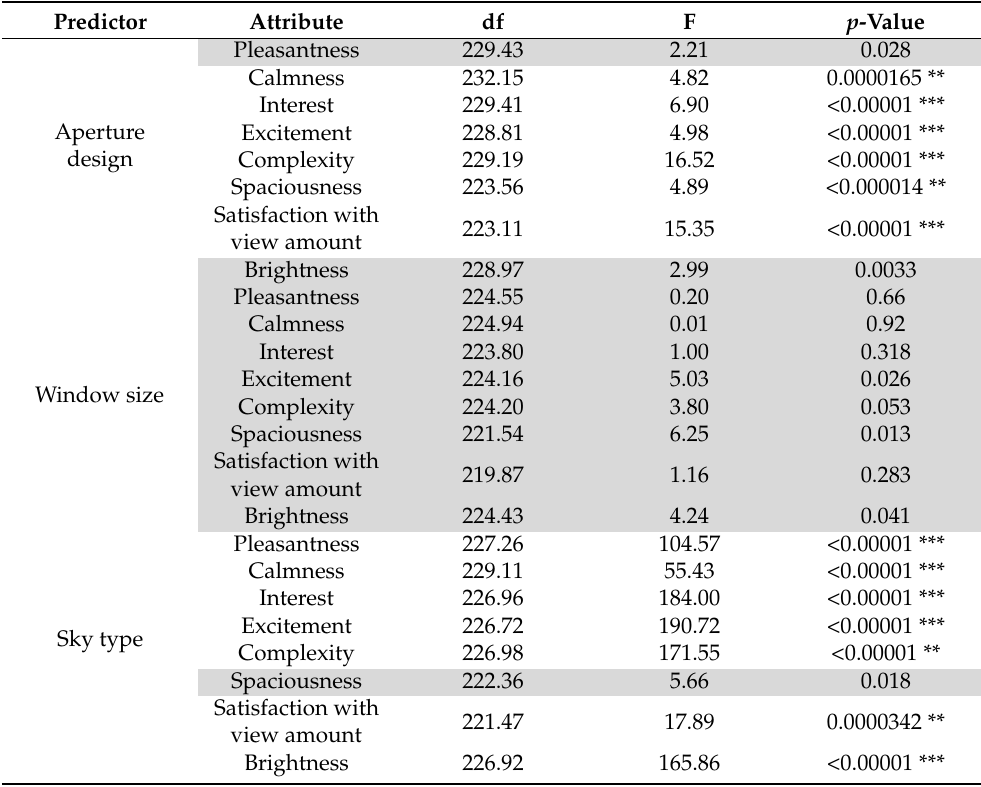
Table 3. Results of the LMM analysis for the main factors of aperture design, window size and sky type on all subjective